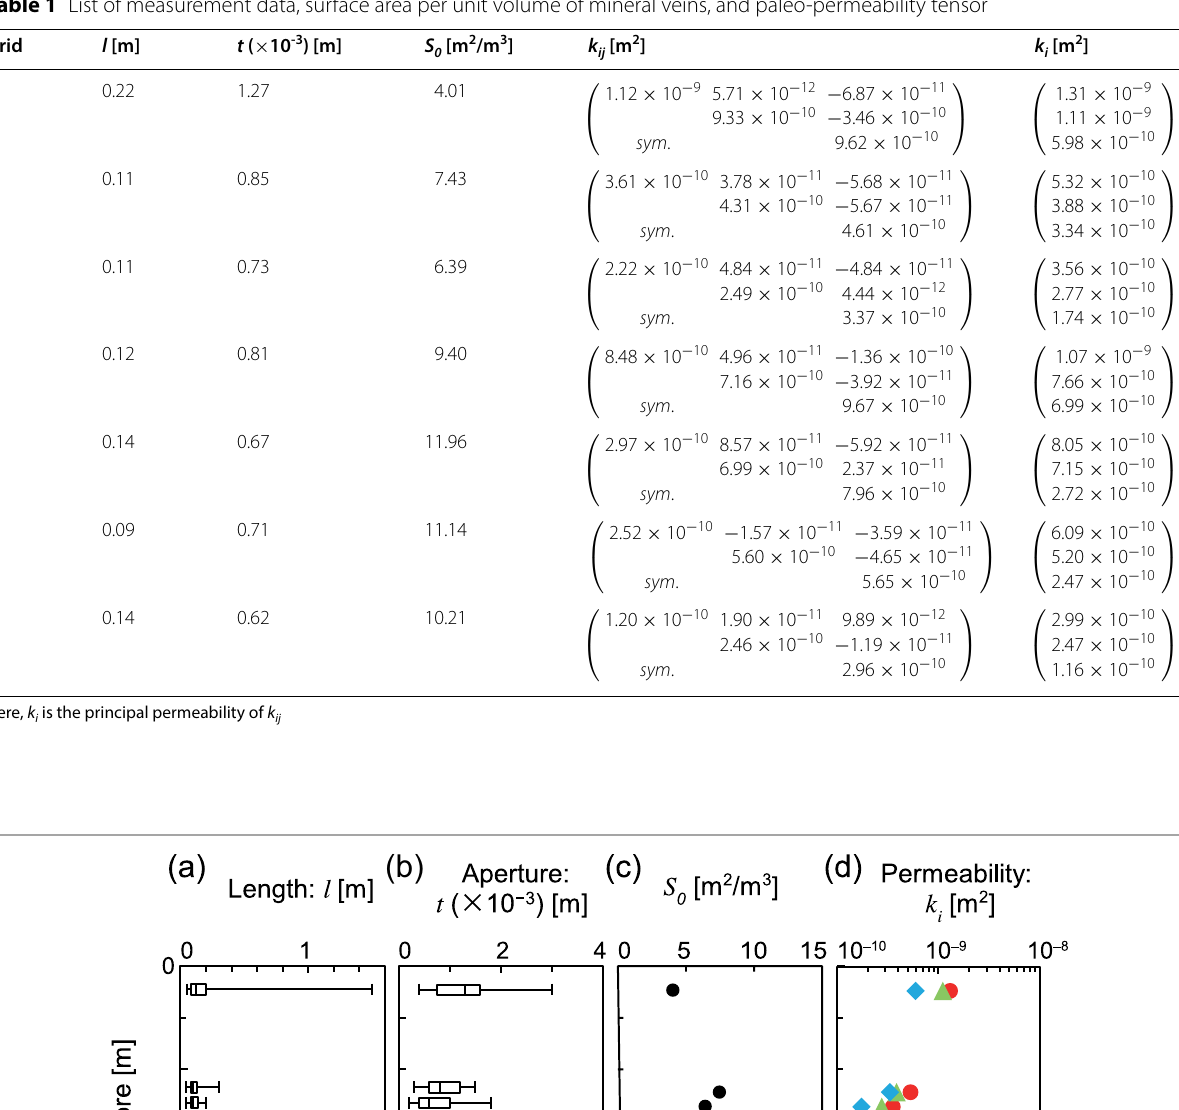
Table 1 List of measurement data, surface area per unit volume of mineral veins, and paleo-permeability tensor